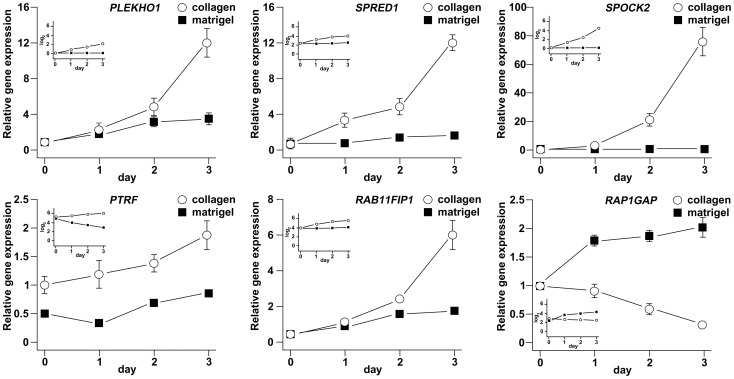
Validation of a subset of candidate genes by qRT-PCR.RNA was harvested from hAT2 cells cultured on collagen or Matrigel at 12 = 2. The relative expressions of SPOCK2, PLEKHO1, SPRED1, RAB11FIP1, PTRF/CAVIN-1, and RAP1GAP were assessed by TaqMan qRT-PCR and normalized to GAPDH and TBP. The fold-changes in relative expression over time are shown as graphs. The smaller, inset graphs show the expression results obtained from the Illumina BeadChip analysis, for comparison.